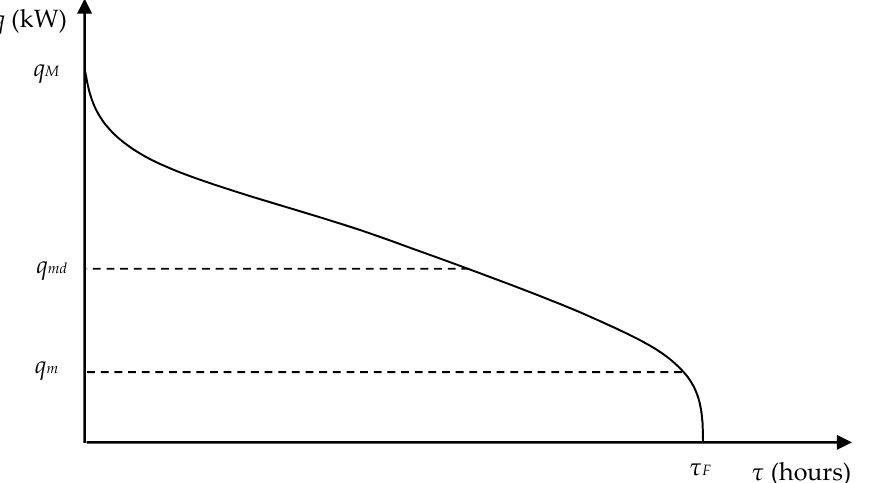
Figure 2. Load duration curve for the heat demand.